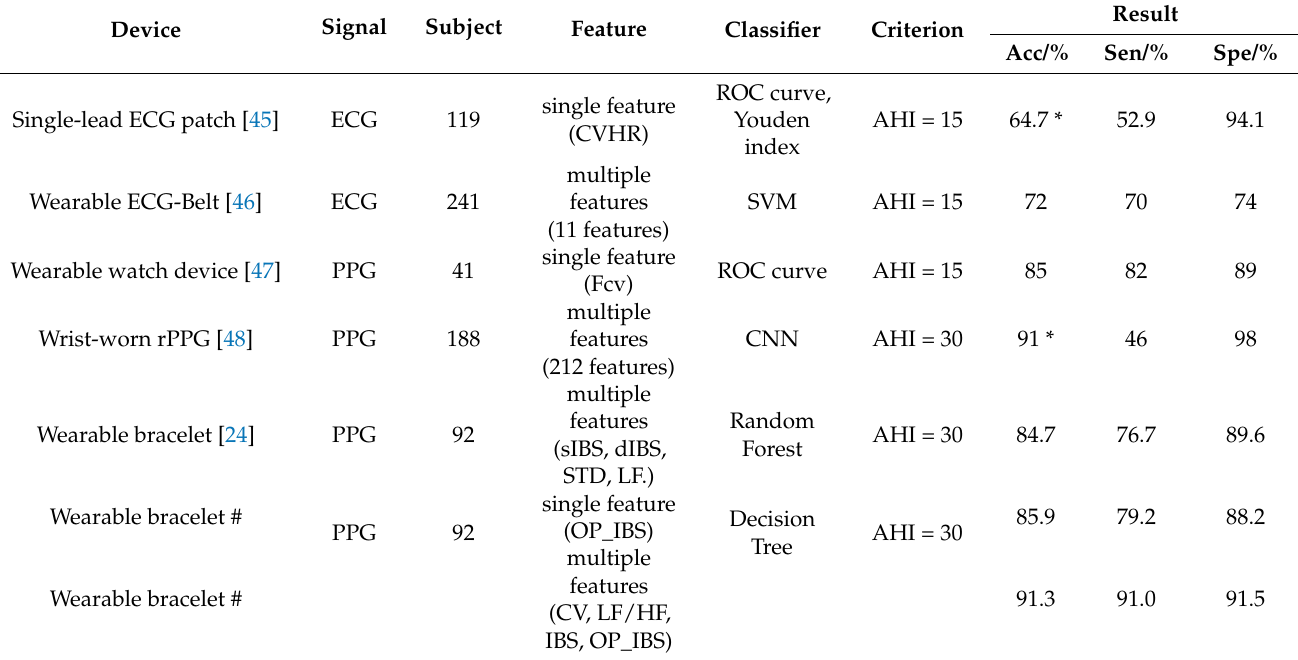
Table 5. Comparison between proposed method and previous studies regarding wearable